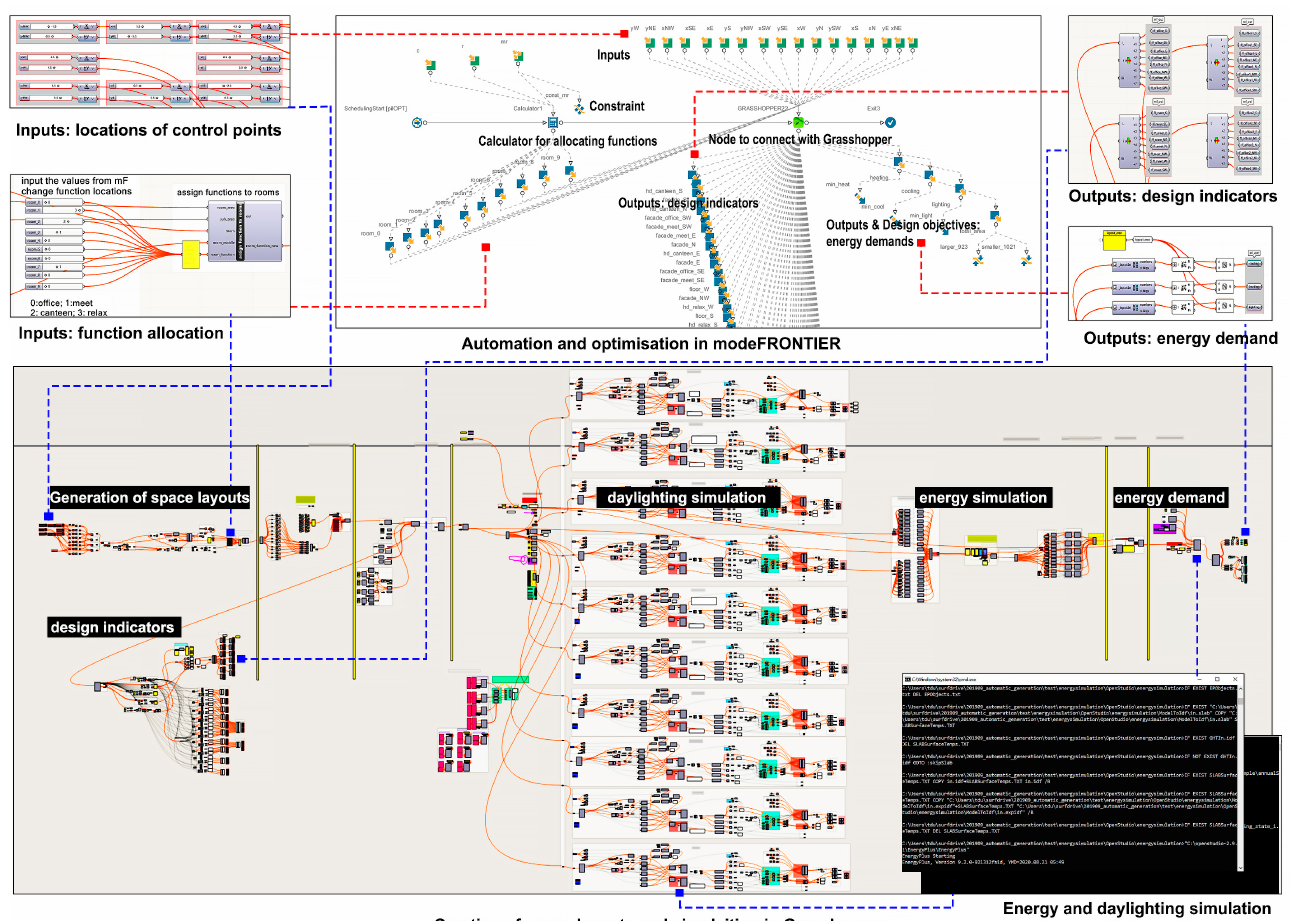
Figure 2. Workflow of the computational method and screenshots of used tools.